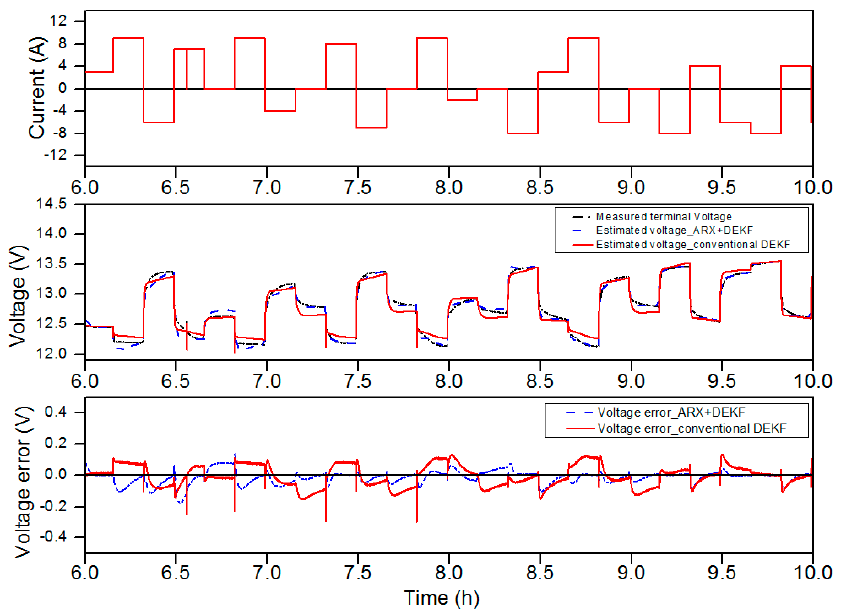
Figure 4. Zoomed in version of Figure 3.